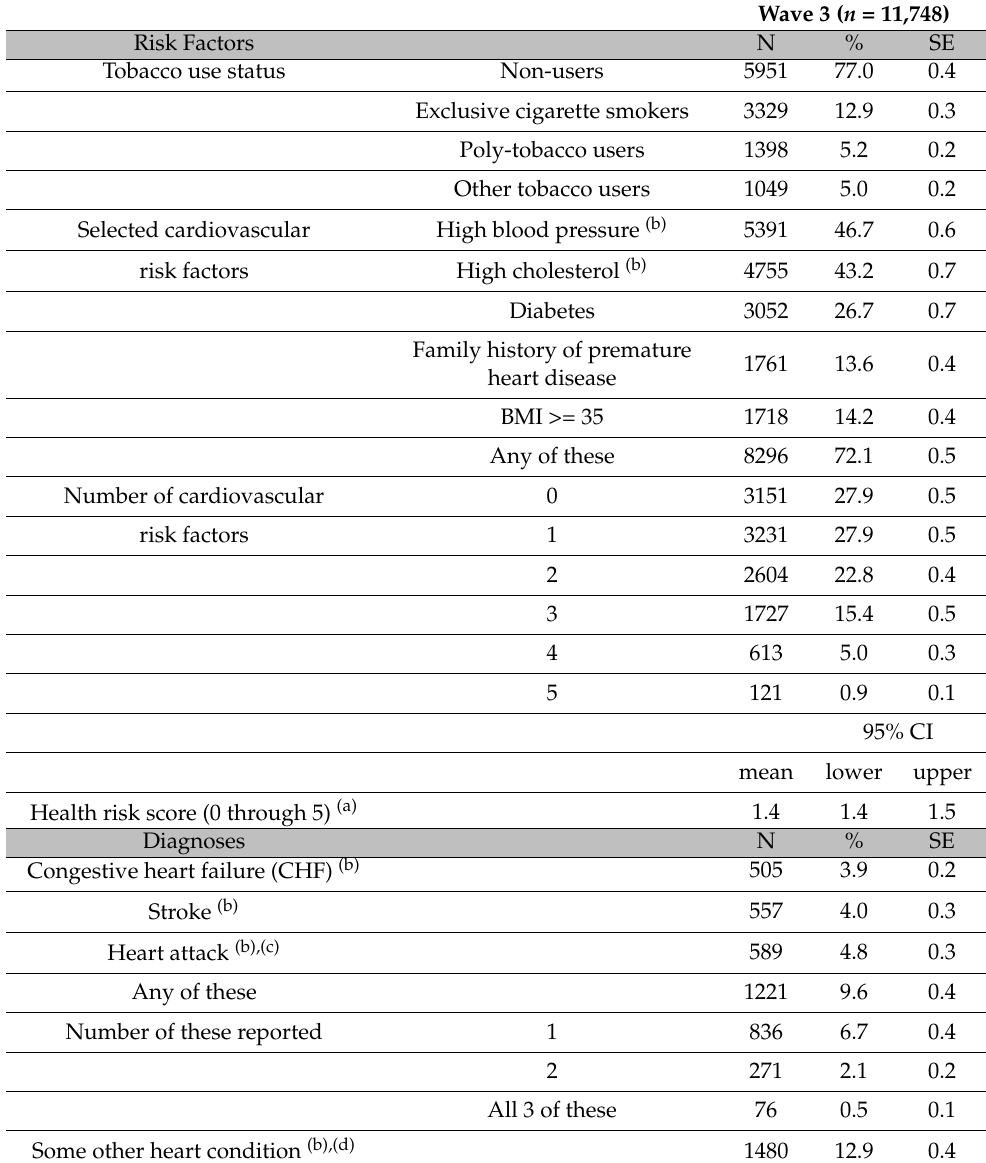
Table 1. Cardiovascular Risk Factors and Diseases Among Adults age 40+ in Wave 3 of the PATH